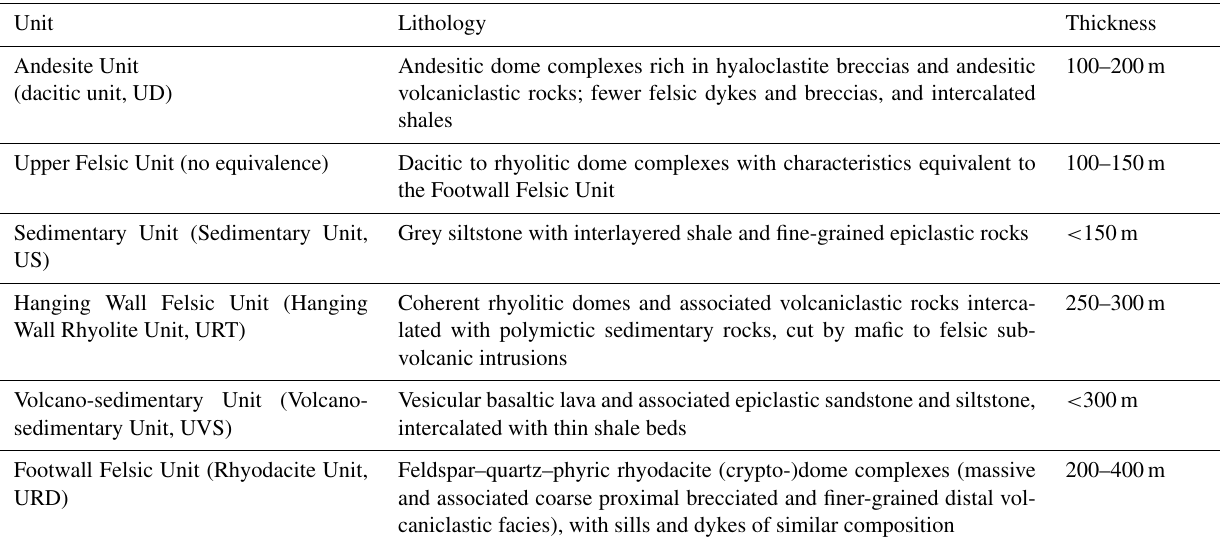
Table 1. Tectonostratigraphic units in the Lomero Poyatos–Aguas Teñidas zone as defined by Conde and Tornos (2020). Local names used by MATSA and previous works in Aguas Teñidas are given in brackets, with the original acronyms in Spanish for reference.